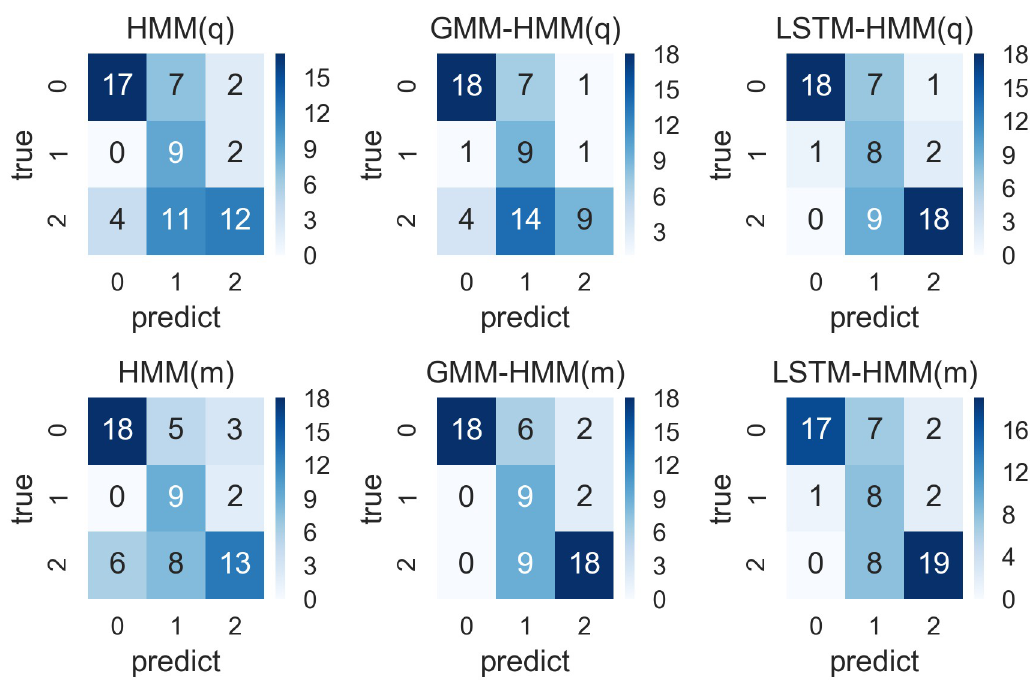
Fig 8. Confusion matrixes for prediction results from HMM, GMM-HMM and LSTM-HMM with monthly or quarterly input and 4-year time window.